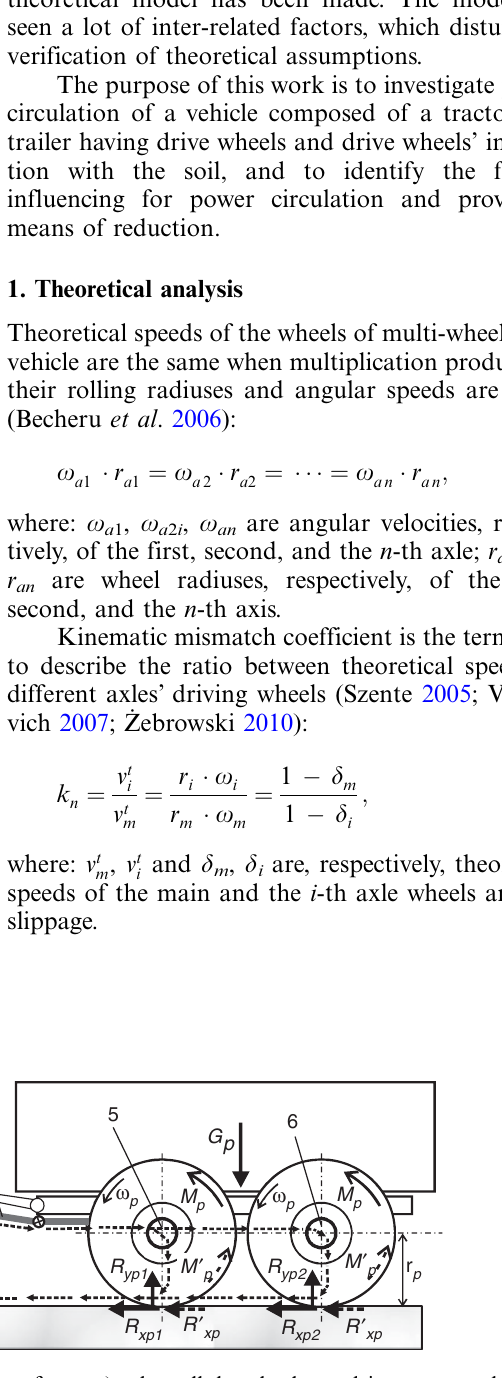
Fig. 1. ‘‘Tractor (cid:2) trailer’’ kinematic diagram (with the circulation of power), when all the wheels are driven, except the front axle of the tractor: 1 (cid:2) engine; 2 (cid:2) transmission of the tractor; 3 (cid:2) rear driving axle of the tractor; 4 (cid:2) power take-off (PTO) shaft from tractor to trailer, 5 and 6 (cid:2) front and rear driving axles of the trailer; 7 (cid:2) front axle of the